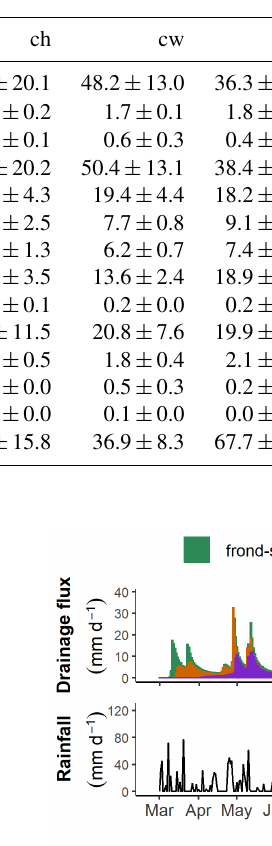
Table 3. Annual leaching losses at 1.5m depth for each experimental treatment from March 2017 to February 2018. Values are area-weighted averages of leaching losses in each management zone (mean ± standard errors, n = 4 plots). Treatments: ch is conventional fertilization– herbicide, cw is conventional fertilization–mechanical weeding, rh is reduced fertilization–herbicide, and rw is reduced fertilization– mechanical weeding. DON is dissolved organic N, and TDN is total dissolved N.